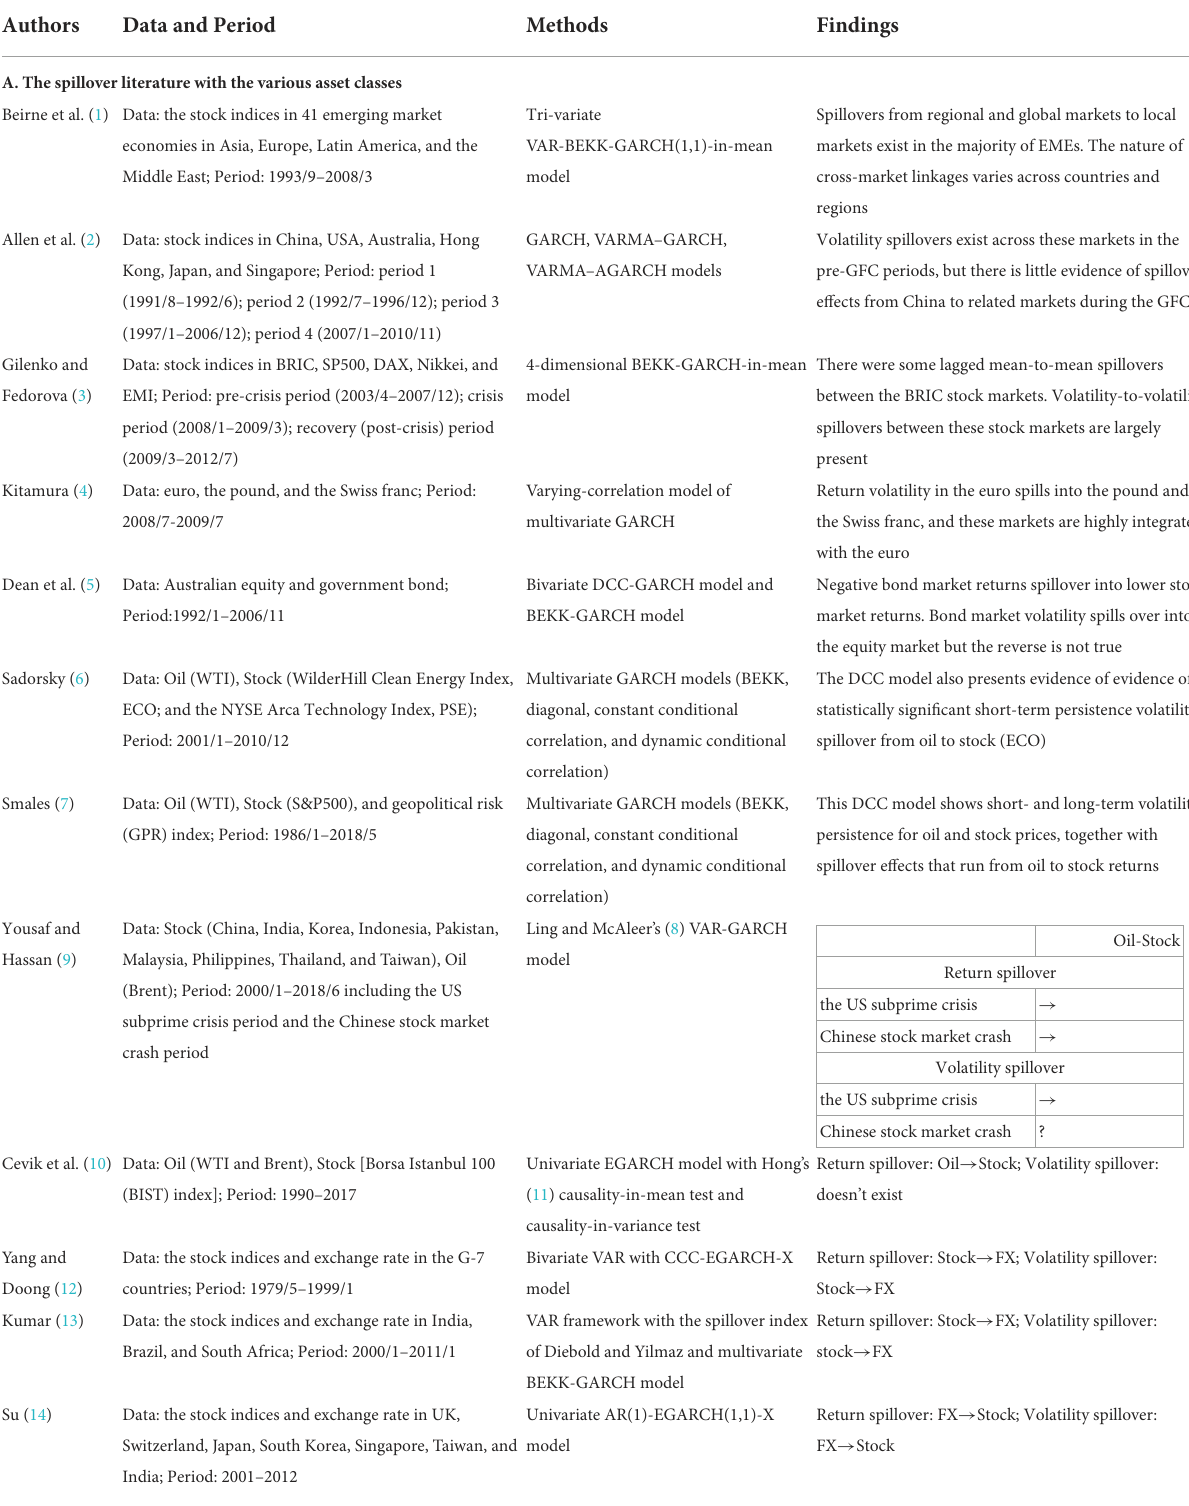
TABLE 1 Overview of the selected previous studies which analyze the return and volatility